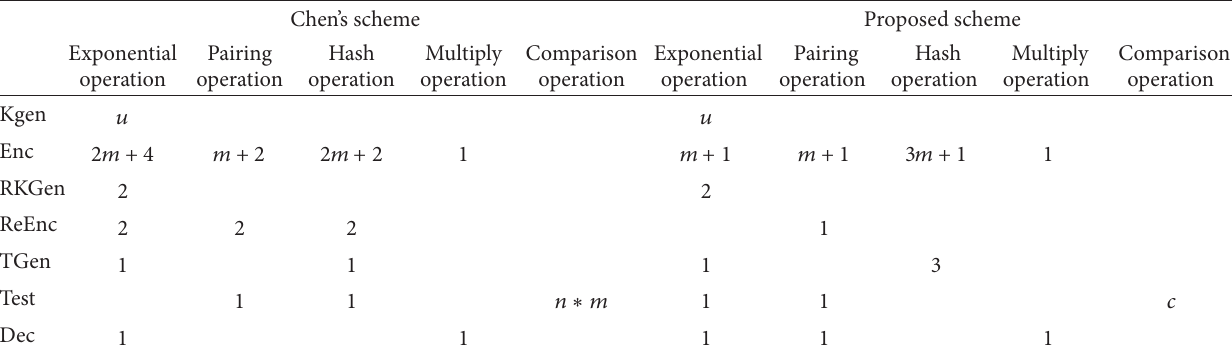
Table 1: Calculation efficiency analysis.